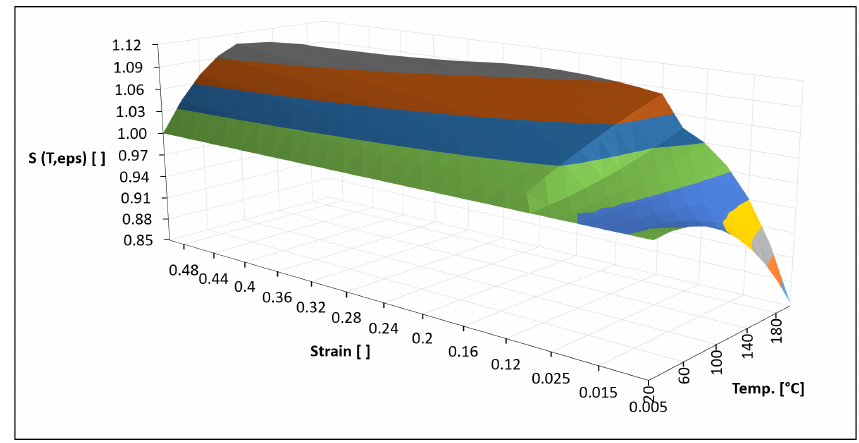
Figure 15. Thermal softening/hardening for the steel MS1700.